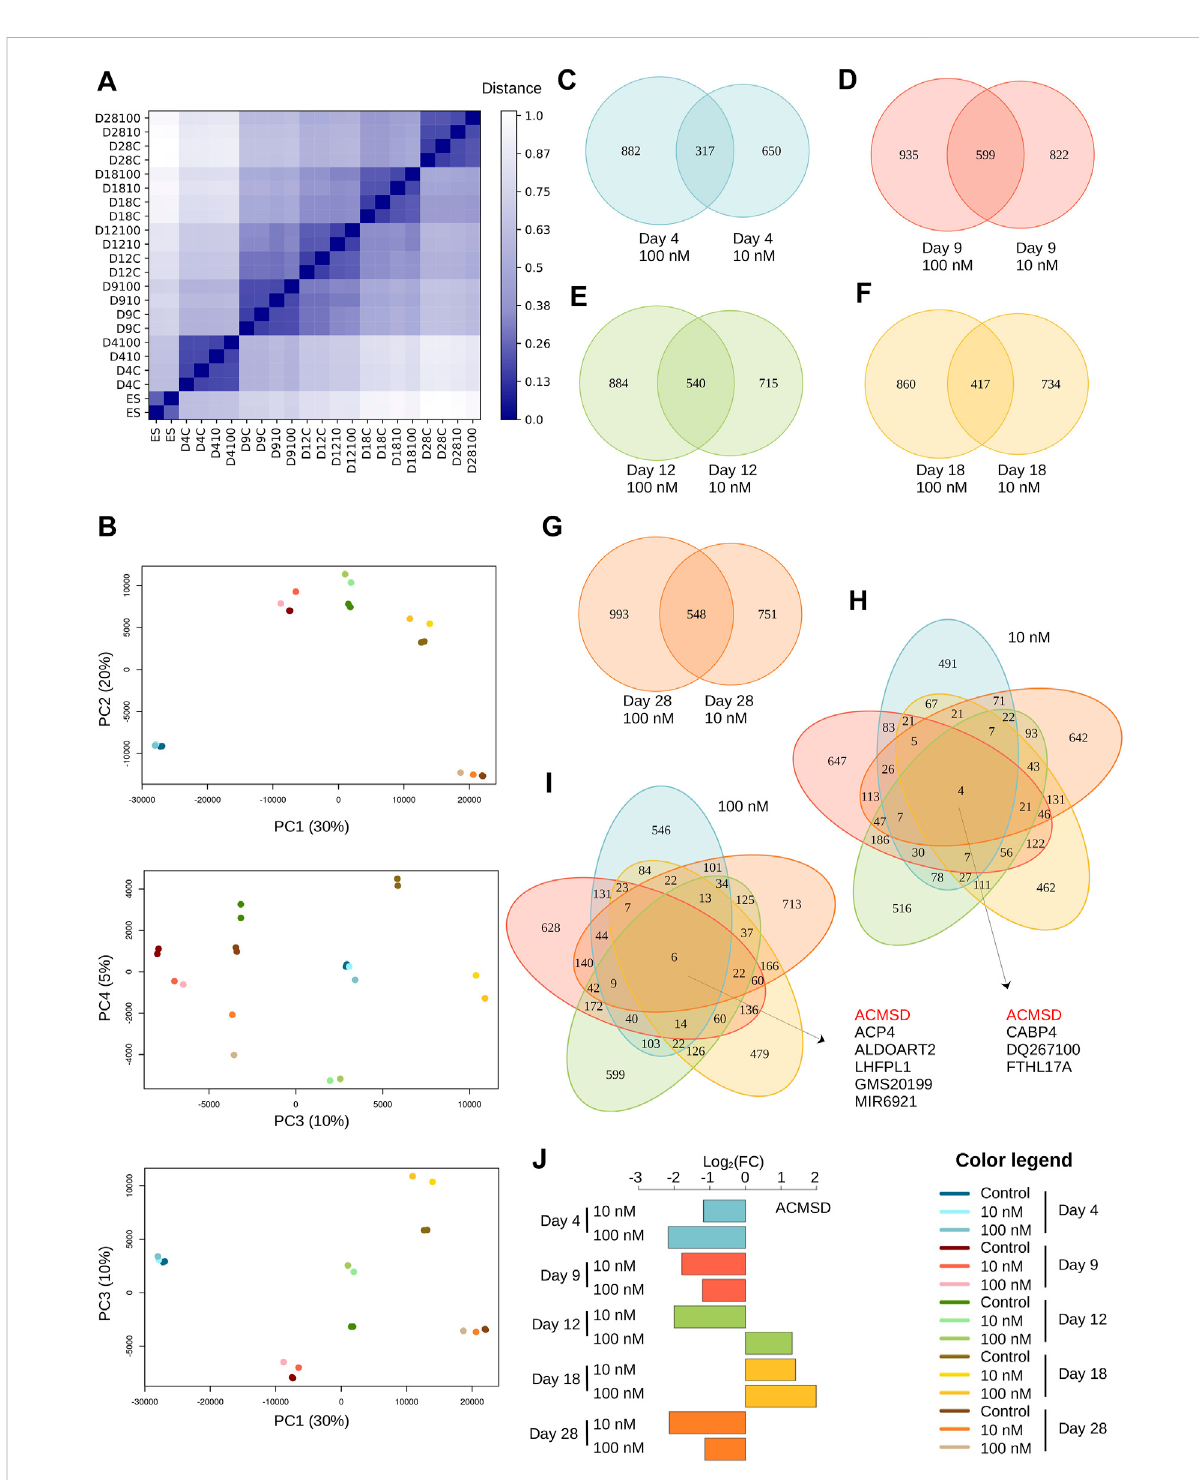
FIGURE 1 TBBPAtreatmenthas longtermeffect ontranscriptome. (A) Distancematrixbetween samples, shown asaheatmap.Color gradient range from dark blue for identical samples (distance = 0) to white (distance = 1). (B) Principal Component Analysis (PCA). Only the fi rst four major components (45%totalvariance)areshown. (C – G) OverlapbetweenDEgenesaftertreatmentwithTBBPA100 nM(left)or10 nM(right),foreachtimepoint. (H – I) All-by-all comparison DE genes lists. (J) Changes of expression level (log2 scale) of ACMSD, the only gene differentially expressed in all experimental